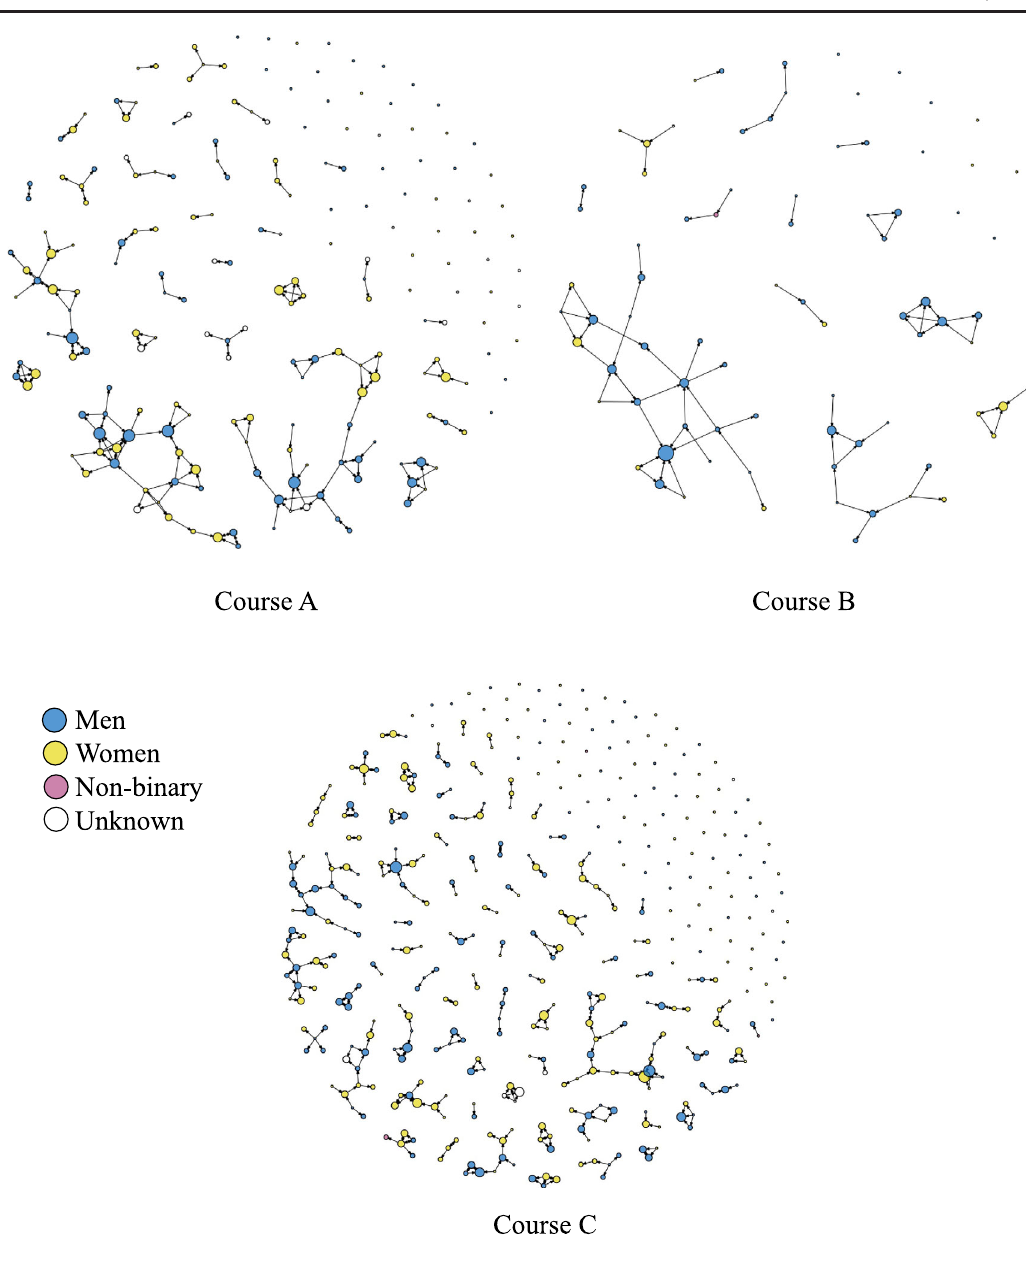
FIG. 2. Lab perception networks. Nodes are colored by self-reported gender and sized proportional to indegree (number of received nominations). Edges point from the nominator to the